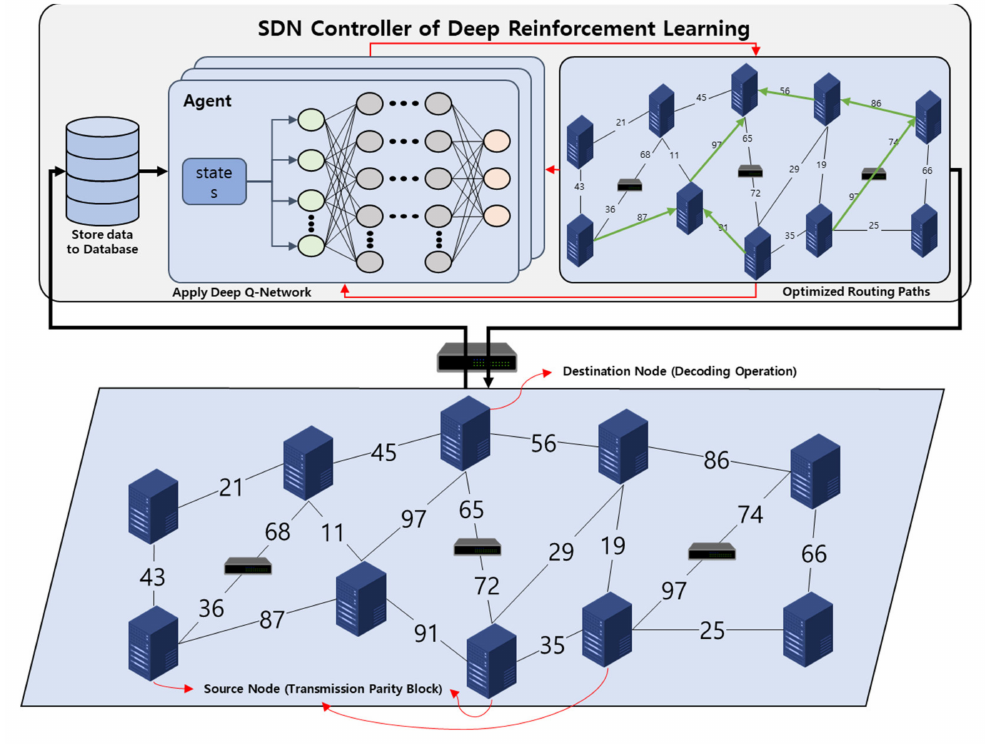
Figure 6. Structure of the DQN-based EC network routing